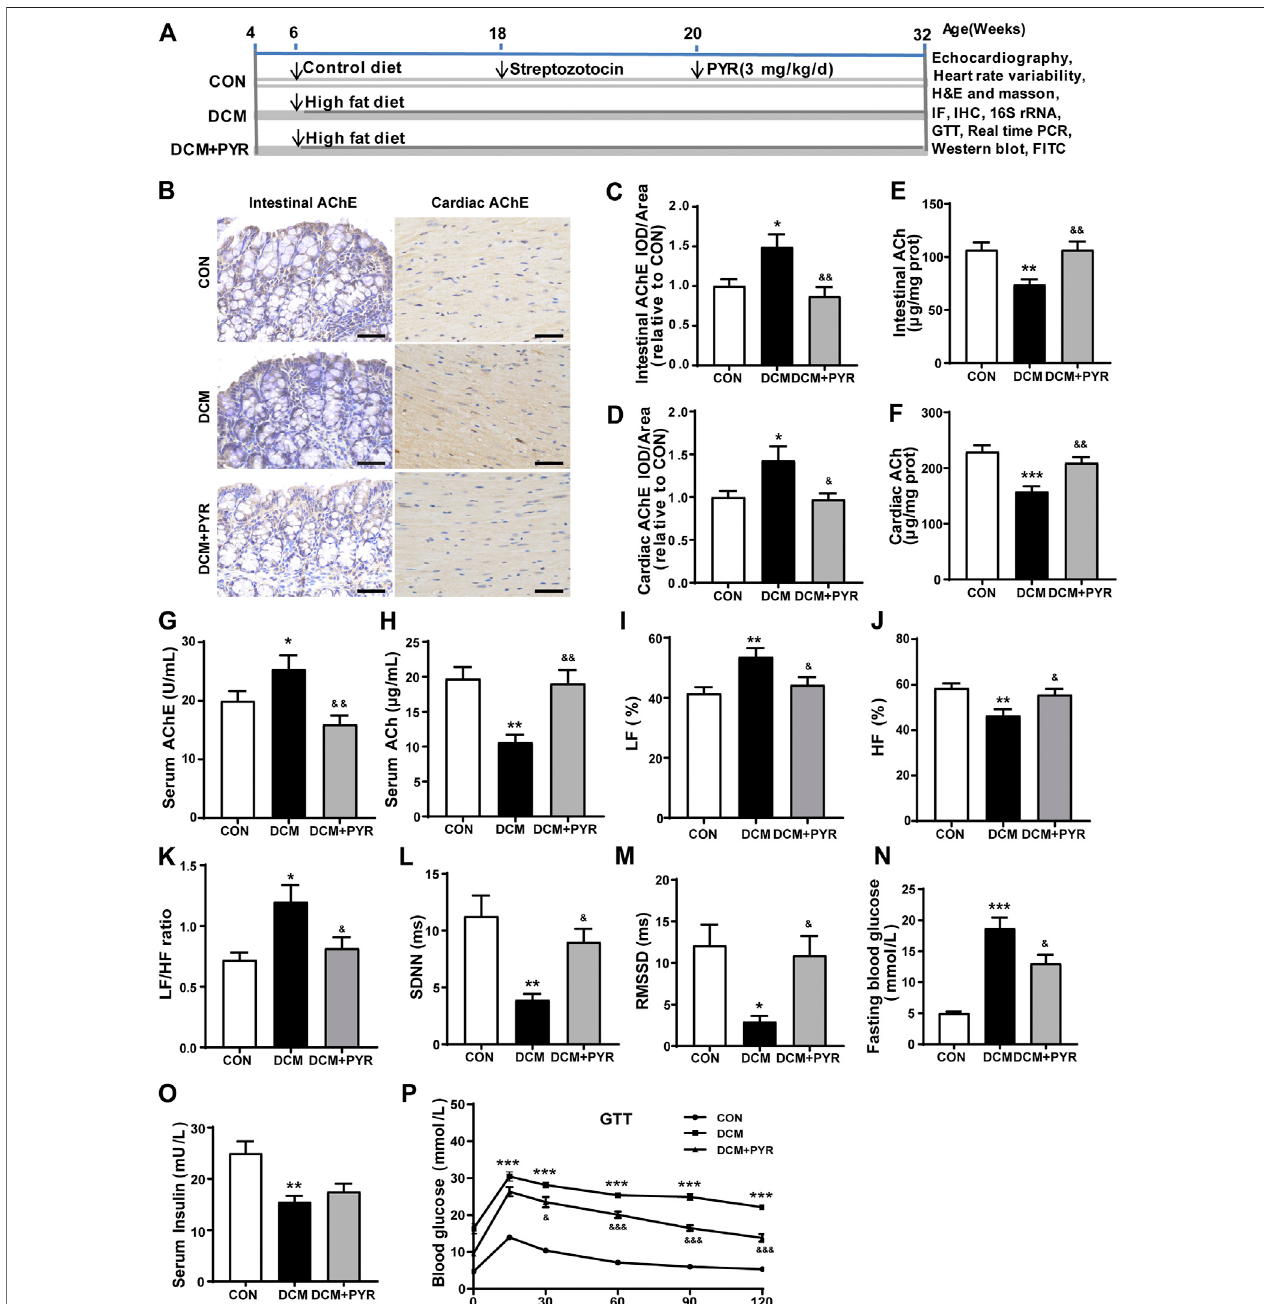
FIGURE 1 | Vagal activity was decreased in diabetic cardiomyopathy mice, and pyridostigmine improved vagal activity and insulin resistance. (A) Experimental protocol. (B – D) Immunohistochemical analysisof AChEexpression in intestinal and cardiac tissues; scale bar (cid:1) 50 μ m. (E,F) Intestinal and cardiac ACh concentrations. (G,H) SerumAChEactivityandAChconcentration. (I – K) LF,HF,andLF/HFratio. (L,M) SDNNandRMSSD. (N) Fastingbloodglucoseconcentrations. (O) Seruminsulin levels. (P) GTT. Data are expressed as the mean ± SEM. n (cid:1) 6 – 8. * p < 0.05, ** p < 0.01, *** p < 0.01, vs. CON; & p < 0.05, && p < 0.01, &&& p < 0.001, vs. DCM.